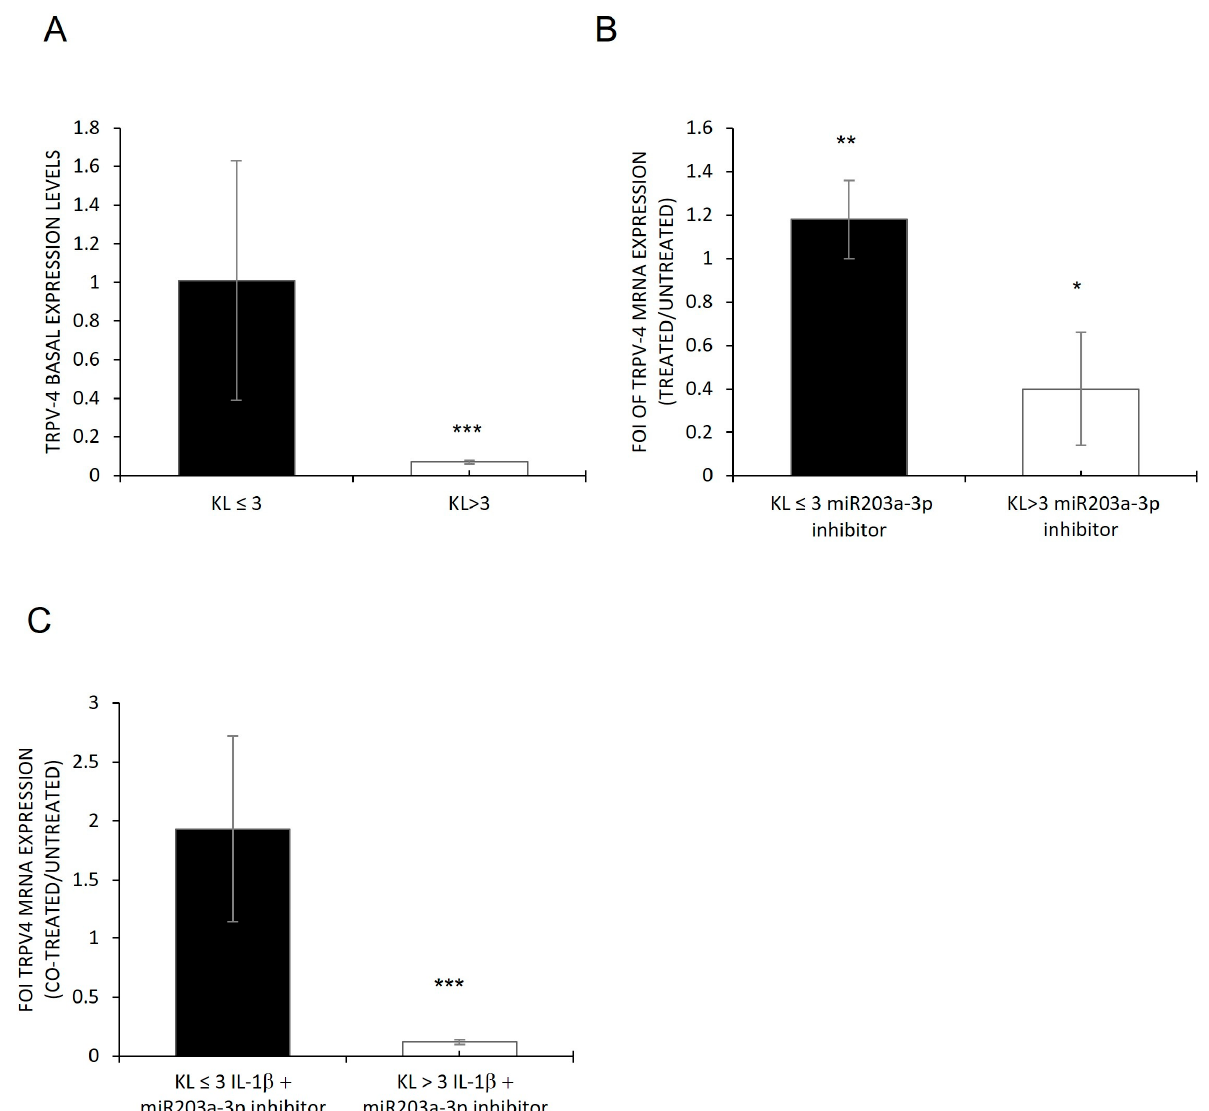
Figure 3. Evaluation of TRPV4 expression on osteoblasts derived from OA patients. qRT-PCR analysis of TRPV4 mRNA expression on OBs derived from the KL > 3 group and the KL ≤ 3 group ( A ) and transfected with miR203a-3p inhibitor ( B ) and co-treated cells versus untreated ( C ). Data are reported as FOI of expression (mean ± SD, n = 4). One-way ANOVA (KL ≤ 3: F = 6.74, p = 0.003; KL > 3: F = 24.37, p < 0.0005); multiple comparisons (* p < 0.05; ** p < 0.005; *** p < 0.0005).